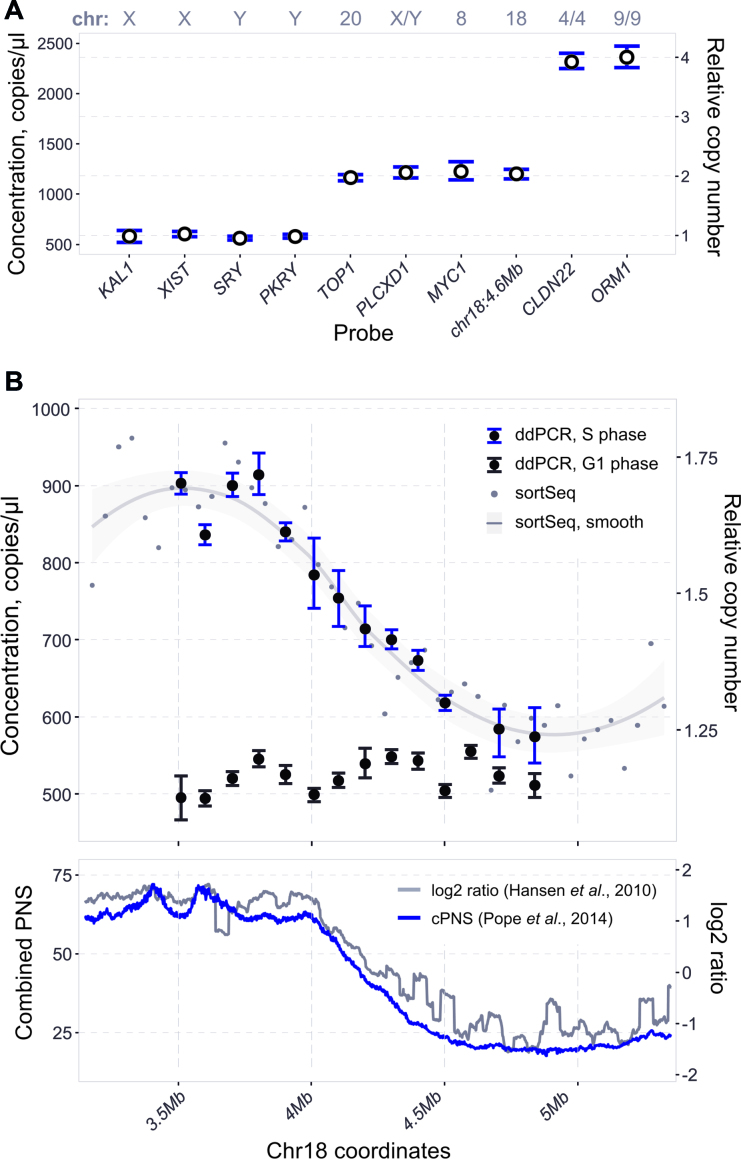
Application of ddPCR to determine relative DNA replication time in human cells. (A) DNA copy number analysis in non-replicating human cells. DNA from male MRC-5 cells arrested in G1 phase of the cell cycle was analysed by ddPCR with probes targeting sex chromosomes, autosomal chromosomes and duplicated genes. Relative copy number was calculated as a mean concentration of all probes adjusted by copy number. (B) DNA concentration analysed by ddPCR across a known replication timing transition zone on chromosome 18. Top: non-replicating control from FACS-enriched G1 HeLa cells, as well as FACS-enriched S phase HeLa cells analysed by ddPCR and sortSeq. Note that G1 and S phase samples, while coming from the same initial population of cells, are independent DNA samples and their absolute concentration cannot be compared. Bottom: repli-seq data of the corresponding genomic region from (14,41). cPNS - combined percentage-normalised signal.